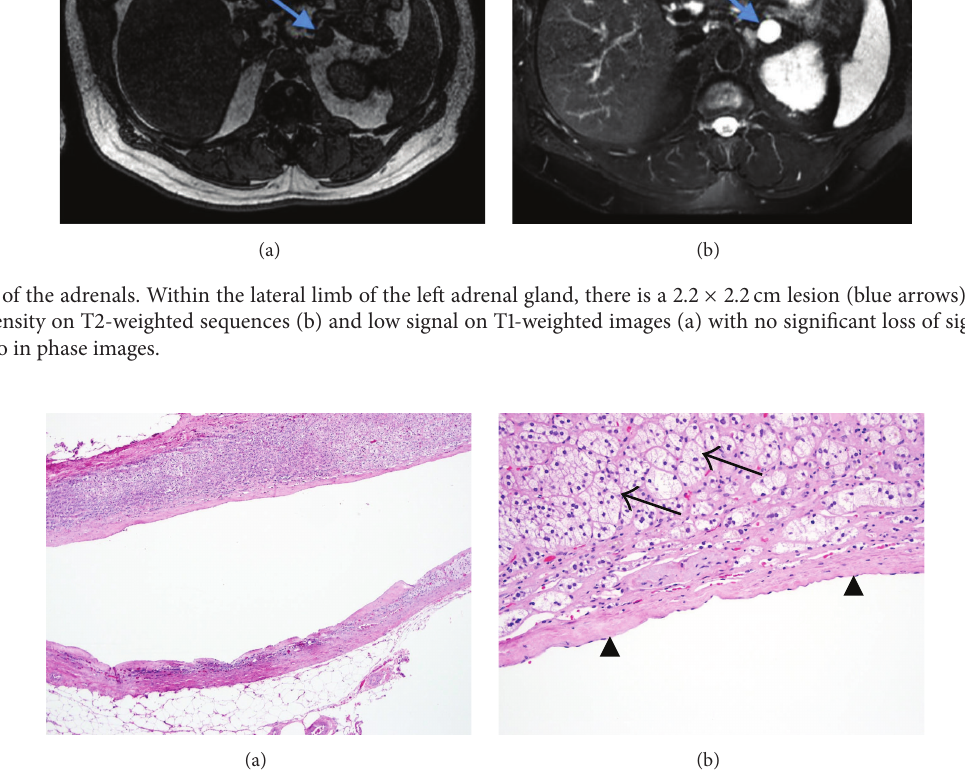
Figure2:(a)Grosspathologydemonstrateda2 cmfluid-filledcyst.Hematoxylinandeosinstainatlowmagnificationdemonstratesasmooth- linedcyst.(b)Hematoxylinandeosinstainathighmagnificationshowsendothelialcellsliningthewallofthecysticlesion(blackarrowheads). The stroma contains foamy cells (black arrows) with some mononuclear infiltrates. The entire picture is most consistent with benign vascular